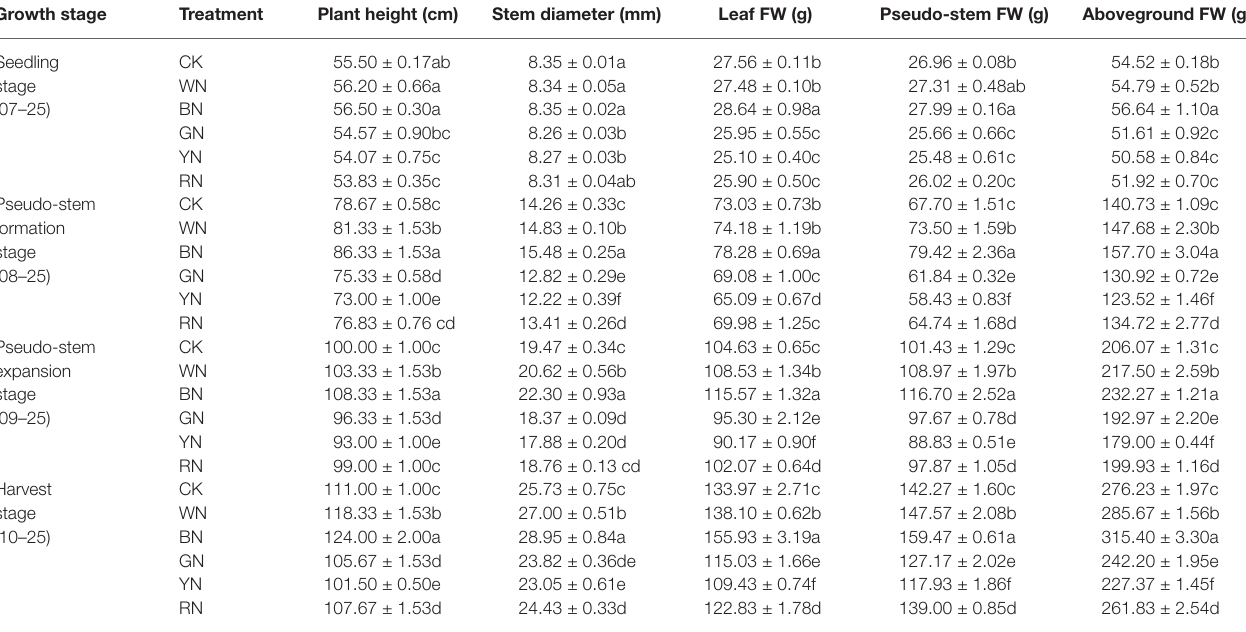
TABLE 2 | Effect of photo-selective nets on the growth of green onion. Growth stage